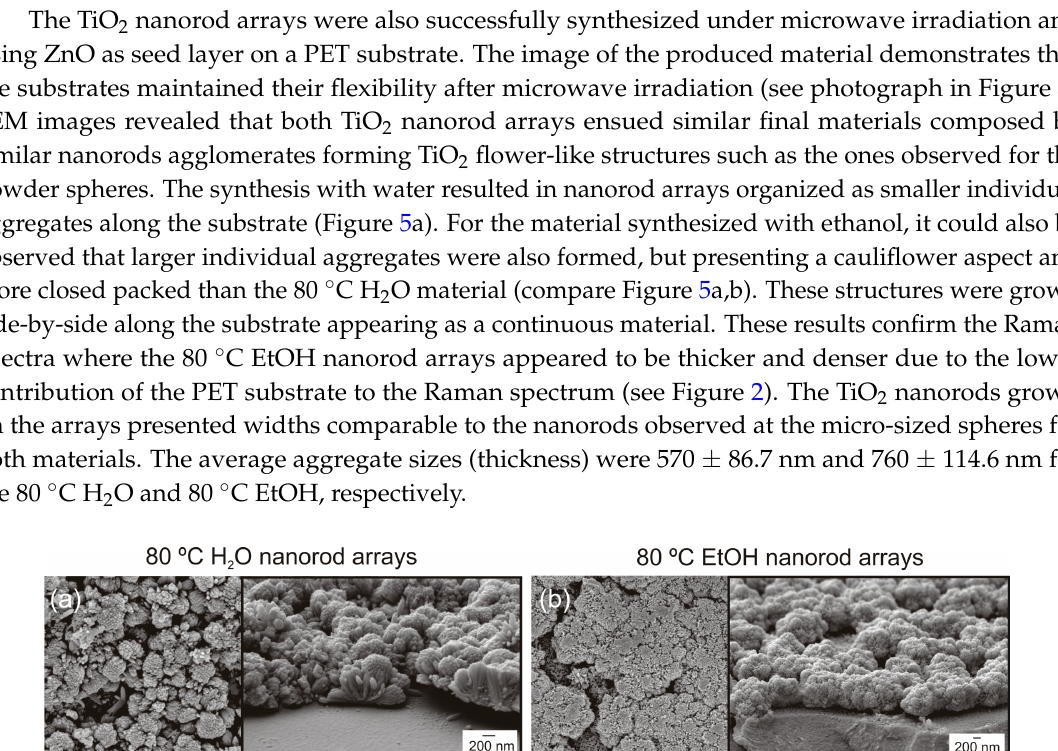
Figure 5. SEM images showing the TiO 2 nanorod arrays produced under microwave irradiation and using: ( a ) water; and ( b ) ethanol as solvents. Both arrays were synthesized with temperature limited to 80 °C. The insets show the magnified image of the arrays and the cross ‐ section of the arrays produced. The array pile ‐ up observed for the 80 °C H 2 O condition is expected to be due to electron beam interactions with the flexible substrate during SEM analysis, causing the array detachment. A photograph of the bended PET substrate with the TiO 2 nanorod arrays is also